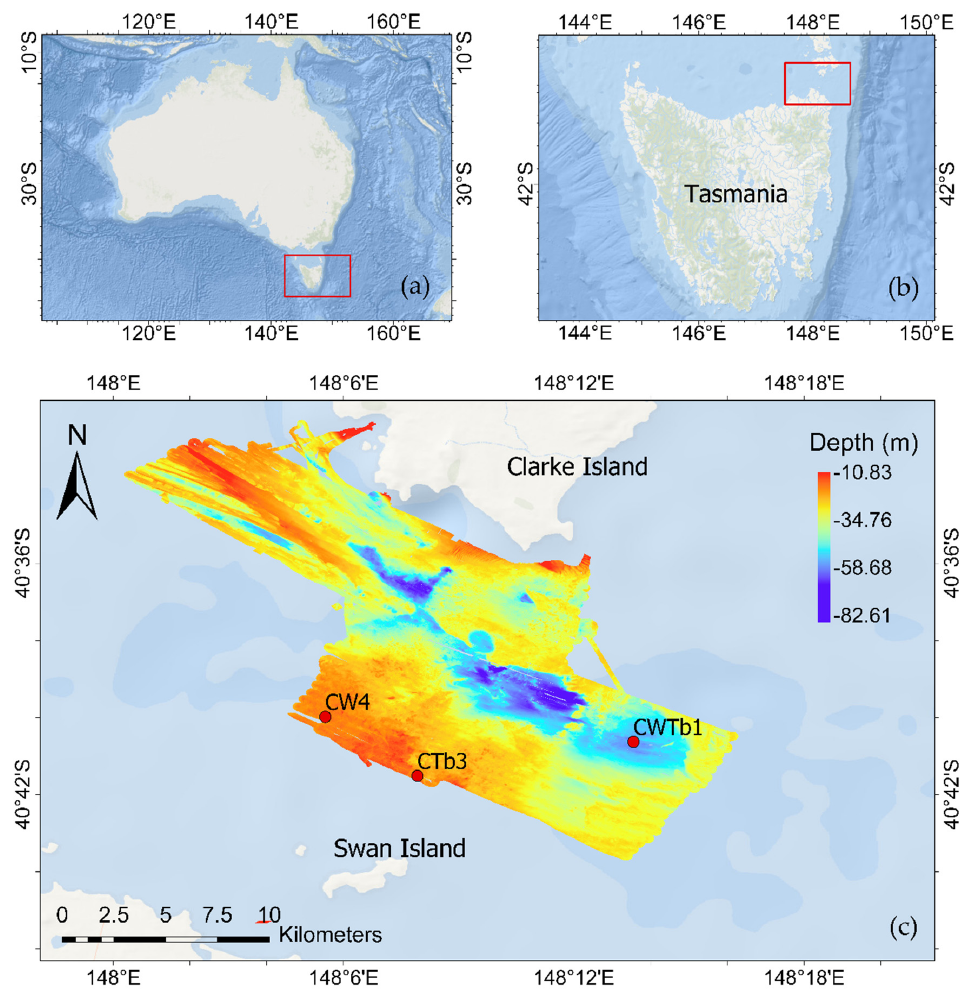
Figure 1. Indication of ( a ) Tasmania in Australia, ( b ) Banks Strait, Northeast Tasmania, and ( c ) measurement sites, located between Clarke and Swan Islands. (Sources: Esri, Garmin, GEBCO, NOAA NGDC and other contributors).